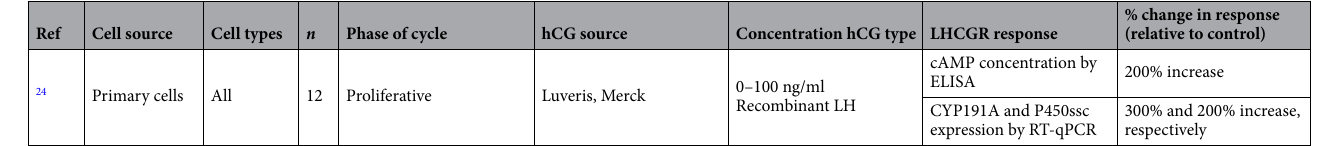
Table 2. Functional activation of LHCGR in primary endometrial cells.